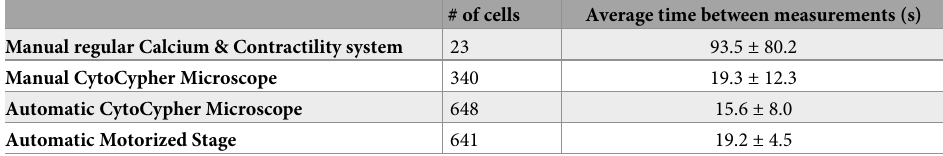
Table 2. Speed of different